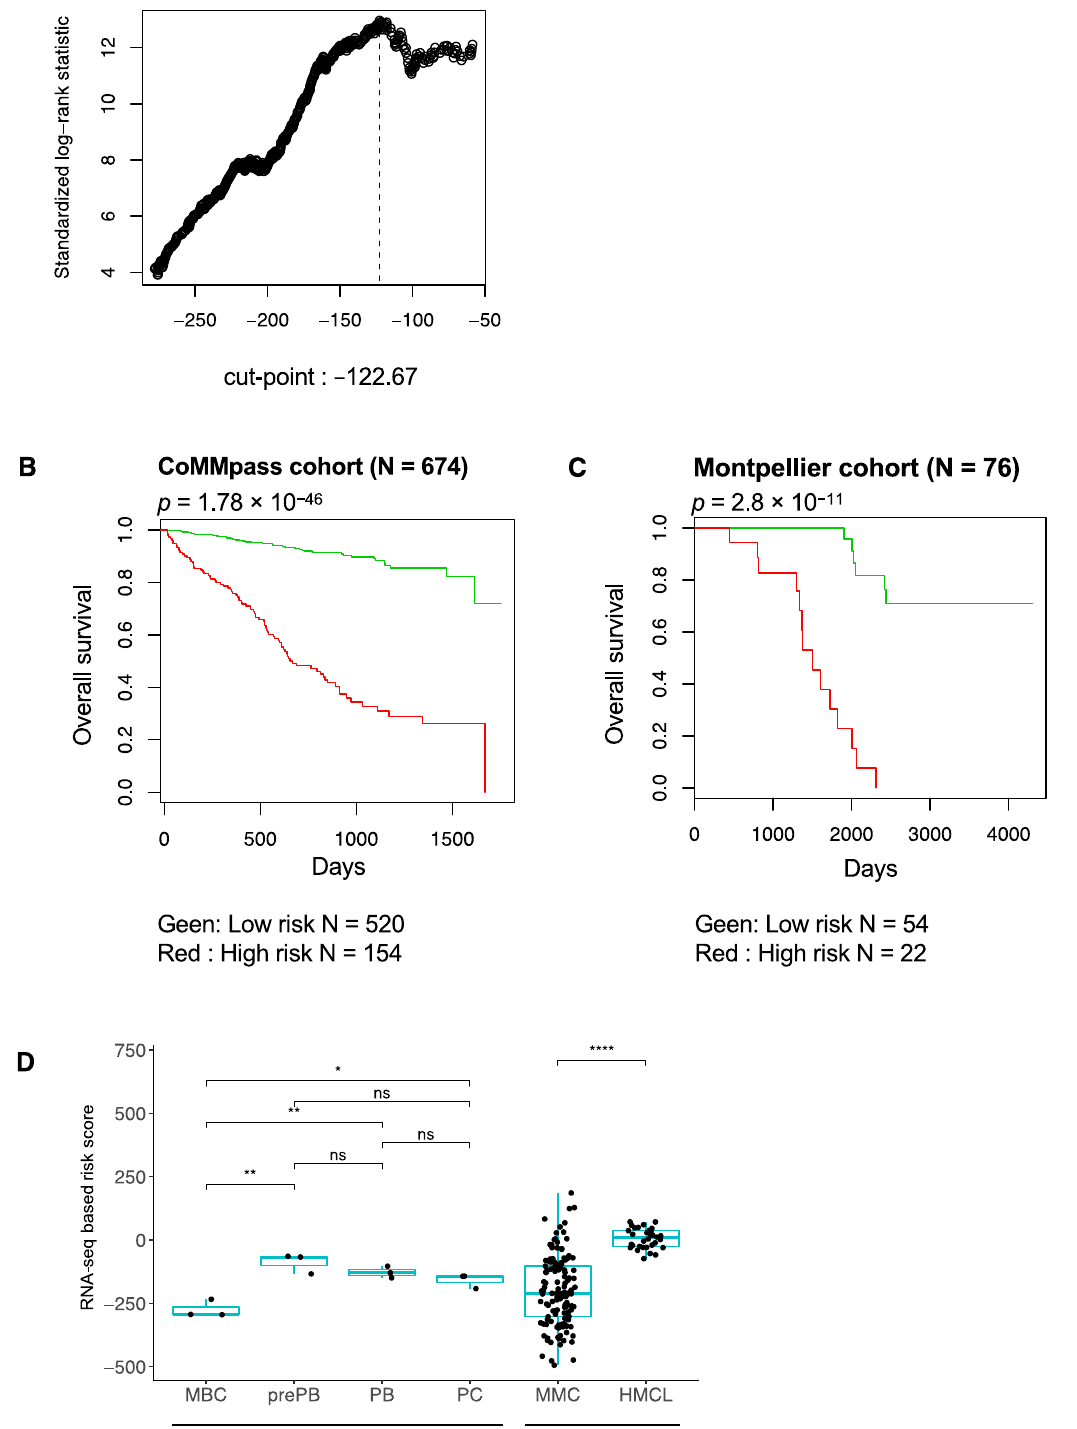
Figure 1. Prognostic value of the RNA-seq-based risk score. ( A ) Maxstat defined cut-point and prognostic value of RNA-seq-based risk score in CoMMpass cohort (n = 674 MM patients). The RNA-seq risk score split MM patients into low- and high-risk groups in two independent cohorts: ( B ) CoMMpass and ( C ) Montpellier (n = 76 MM patients) (OS, Kaplan–Meier curves). ( D ) RNA-seq-based risk score value calculated in normal human B to plasma cell differentiation and in malignant plasma cells from MM patients (n = 129) and HMCLs (n = 33). Wilcoxon test. NS: nonsignificant, * p -value < 0.05, ** p -value < 0.01, **** p -value < 0.0001.